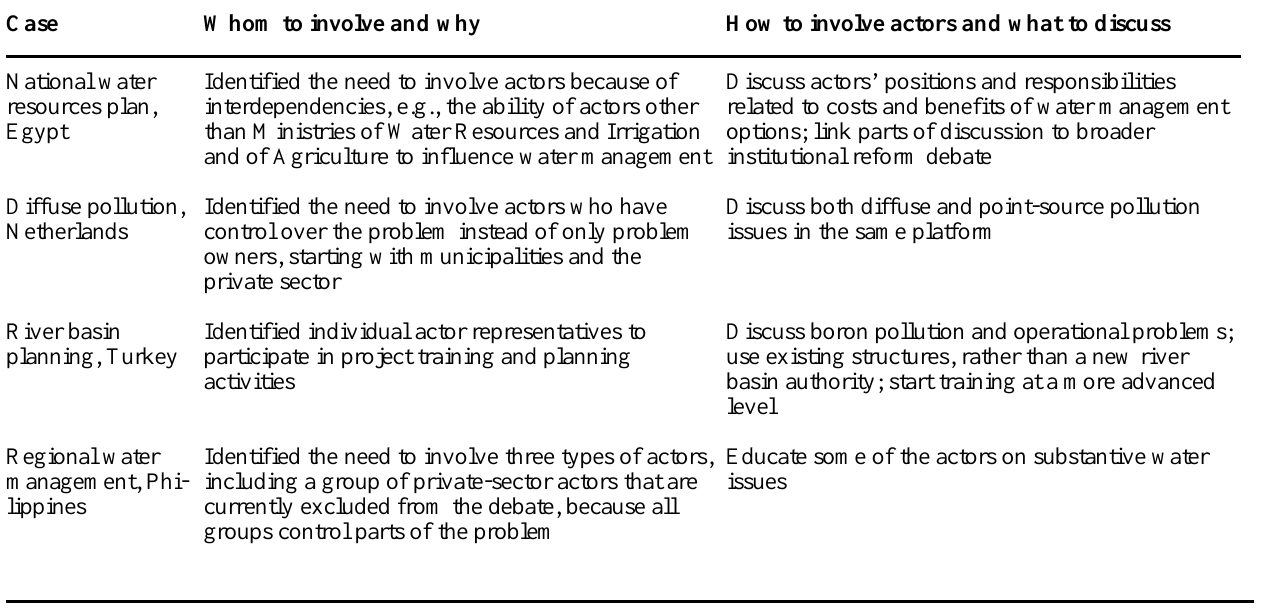
Table 3. Actor analysis output that had implications for the interaction process.